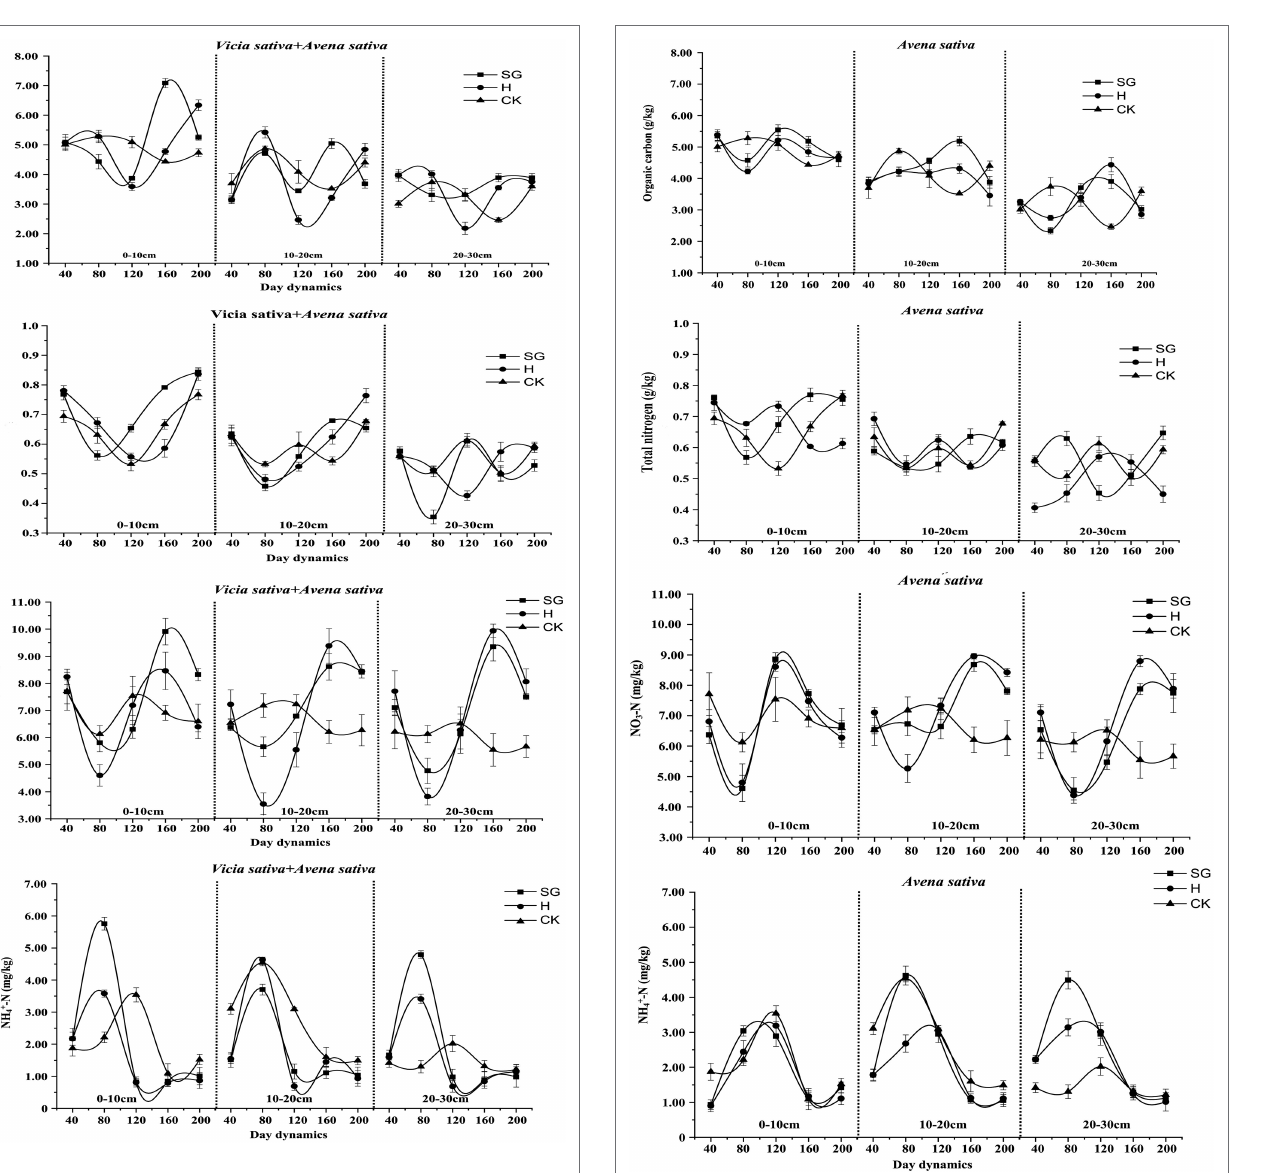
FIGURE 8 | Dynamic changes of soil nutrients of Vicia sativa .